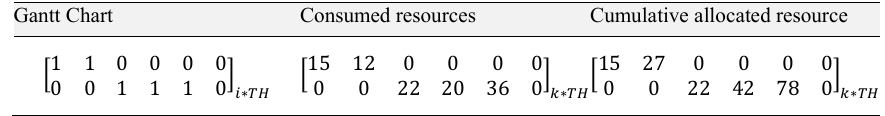
Fig. 3. A representing scheme